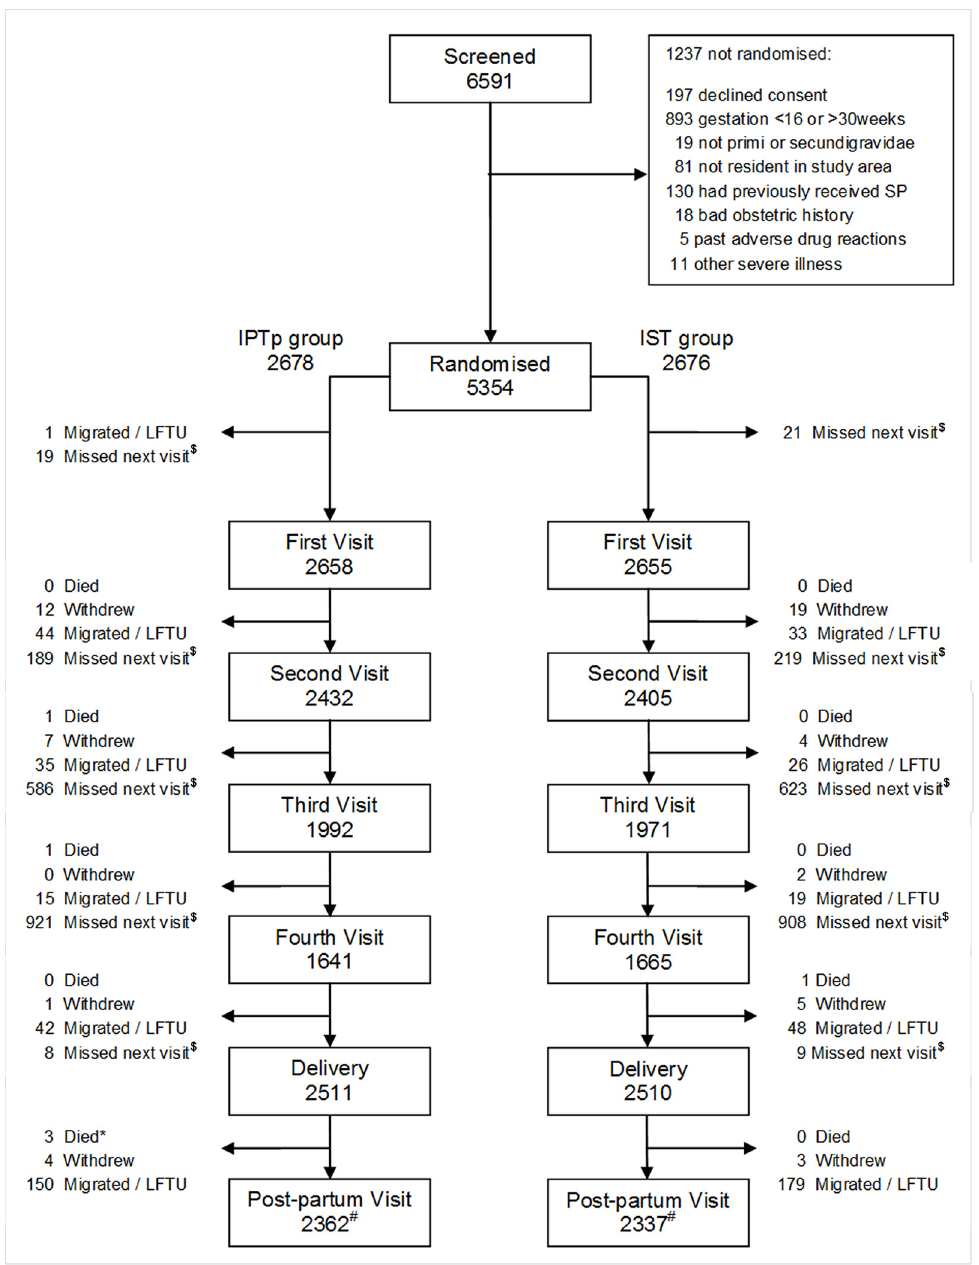
Fig 1. CONSORT Flow Diagram. Footnote: LTFU — Lost to follow-up. * two of these 3 deaths occurred on the day of delivery. $ missed subsequent visit but remained in follow up. # numbers shown at post-partum include 8 and 9 women in IPTp-SP and ISTp-AL groups respectively who were not seen at delivery but who remained in